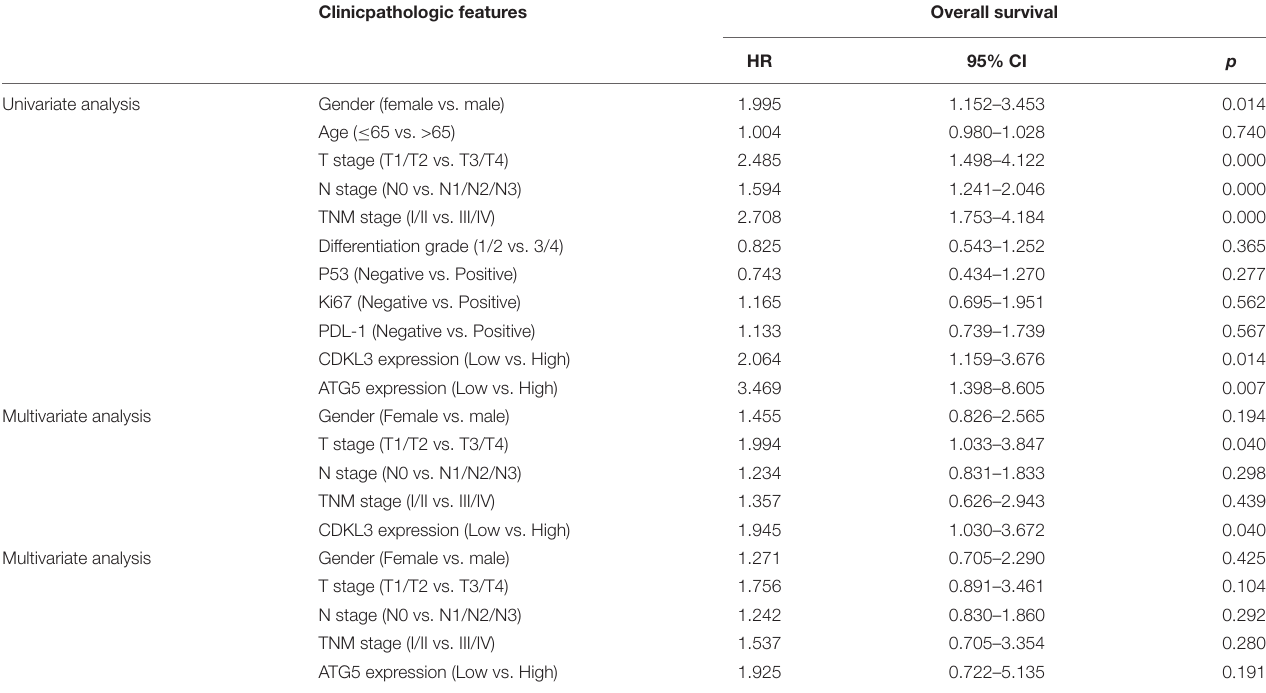
TABLE 3 | Univariate and multivariate analyses of prognostic factors correlated with OS in ESCC patients. Clinicpathologic features Overall survival HR 95% CI Univariate